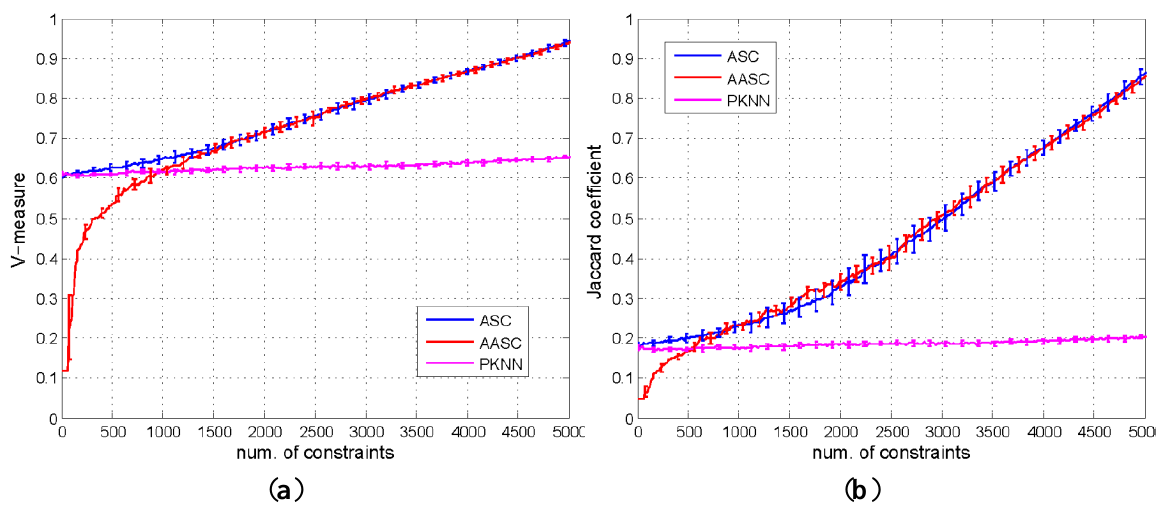
Figure 18. Results obtained on the mixed UCM and WHU-RS dataset. The results are shown as the means and standard deviations of the V-measure and the Jaccard